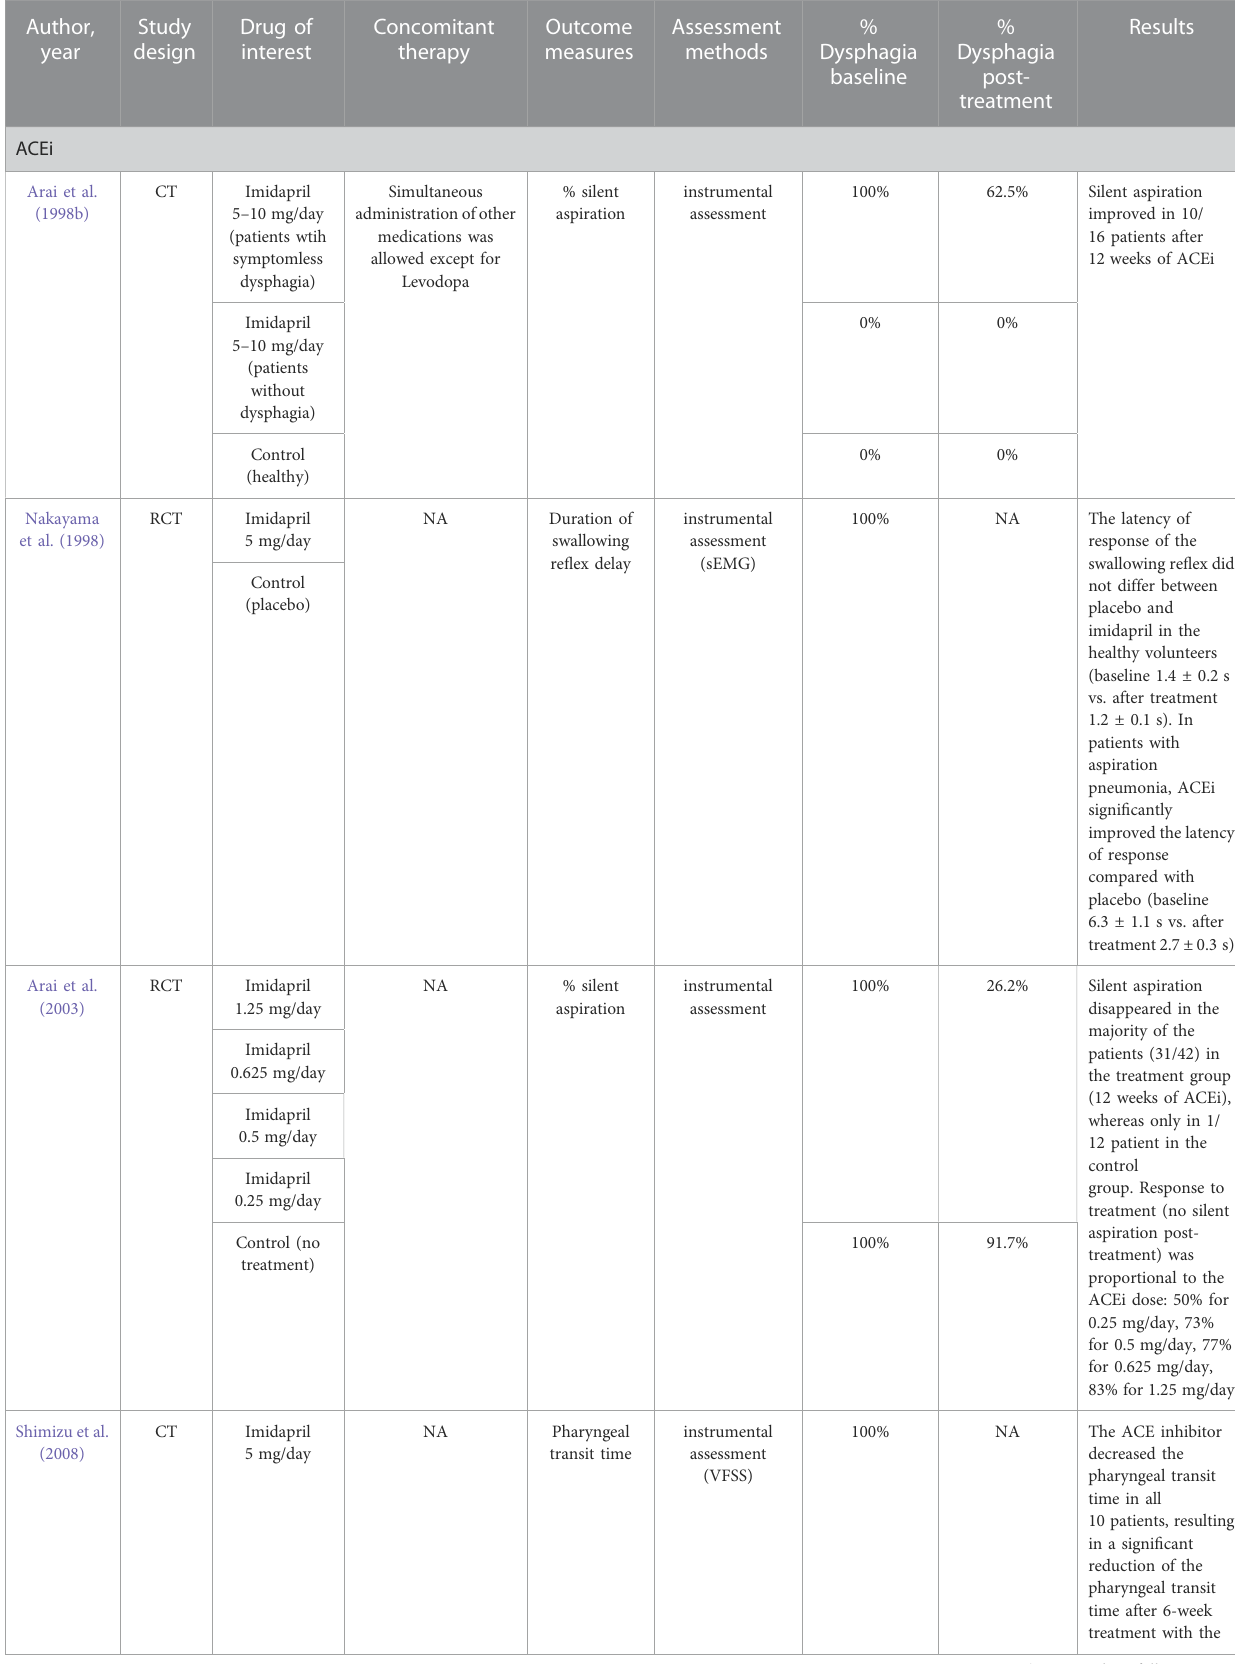
TABLE 2 Effects of pharmacological treatments on